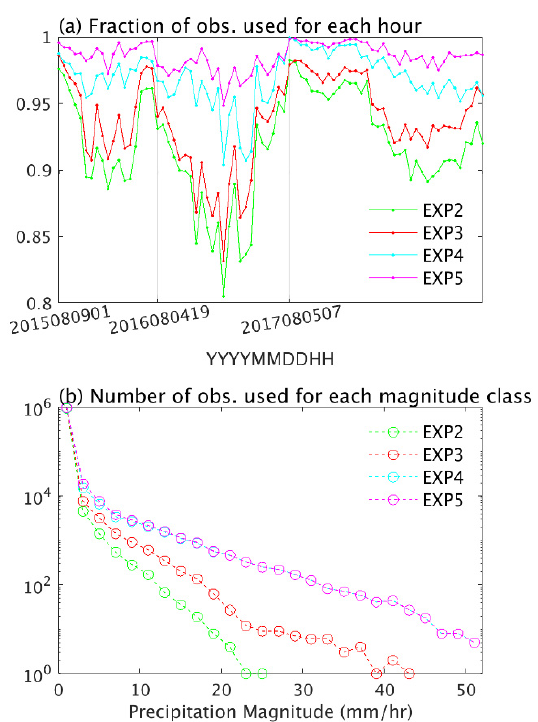
Figure 6. Detection scores of hourly precipitation estimated from assimilation experiments and the OPL experiment at di ff erent thresholds ranging from 1 mm / h to 30 mm / h. EXP2 and EXP3 represent experiments with nontransformed and logarithmically transformed precipitation with constant observation error, respectively; EXP4 and EXP5 are as for EXP2 and EXP3, but with increasing observation error with precipitation magnitude.